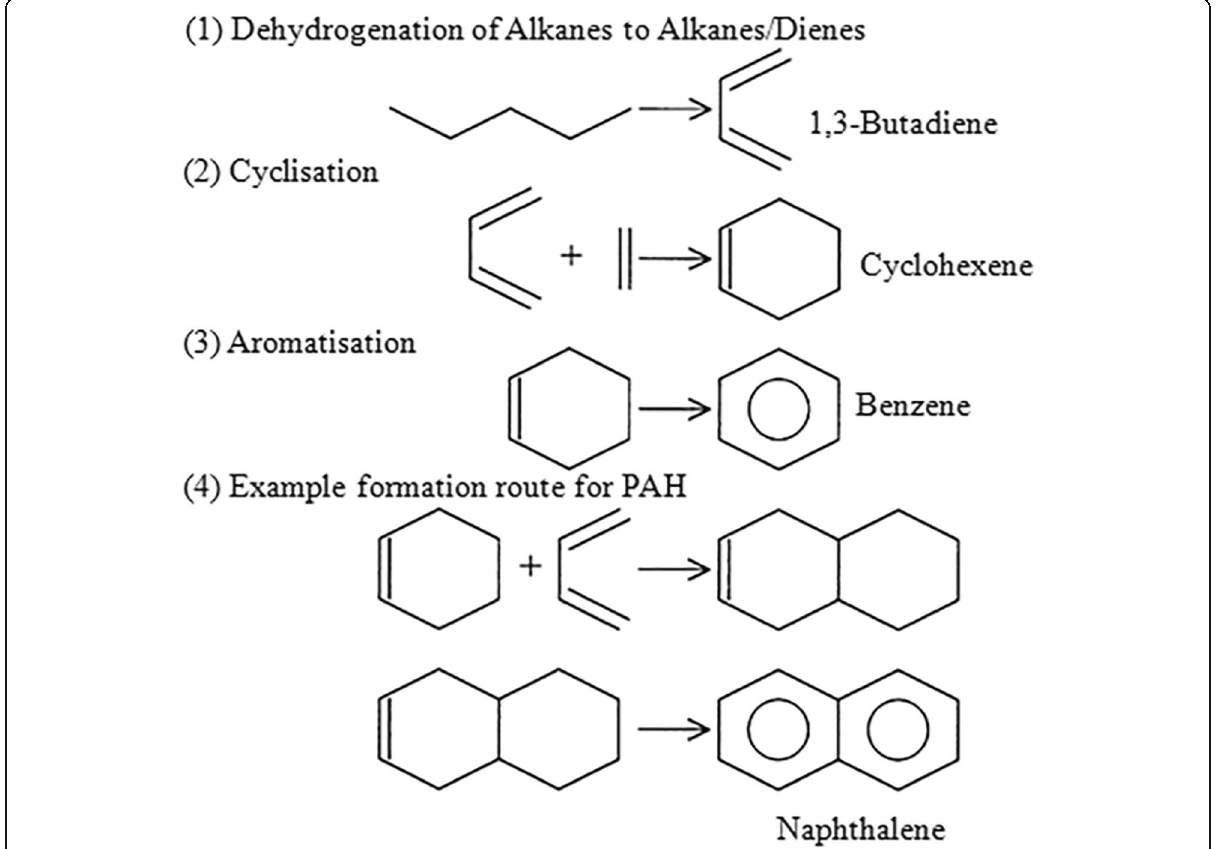
Fig. 4 Diels – Alder reaction for the formation of polycyclic aromatic hydrocarbons